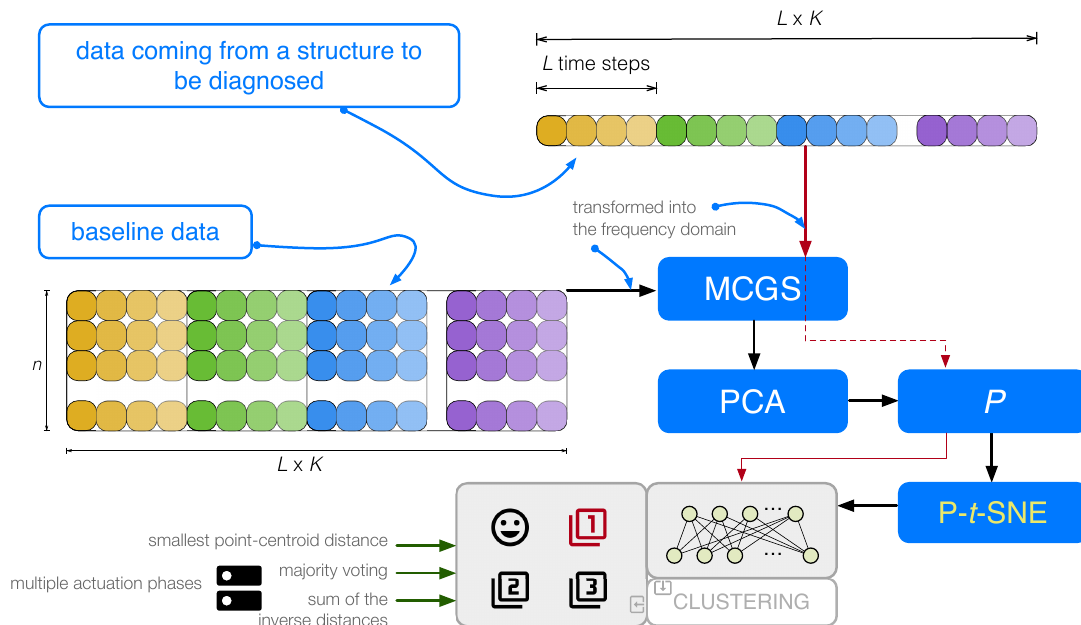
Figure 3. Flowchart of the proposed procedure. Data coming from a structure are first scaled by MCGS and then projected into the PCA model. Finally, P- t -SNE is applied to generate the clusters that will be used in the vibration-based detection and classification of structural